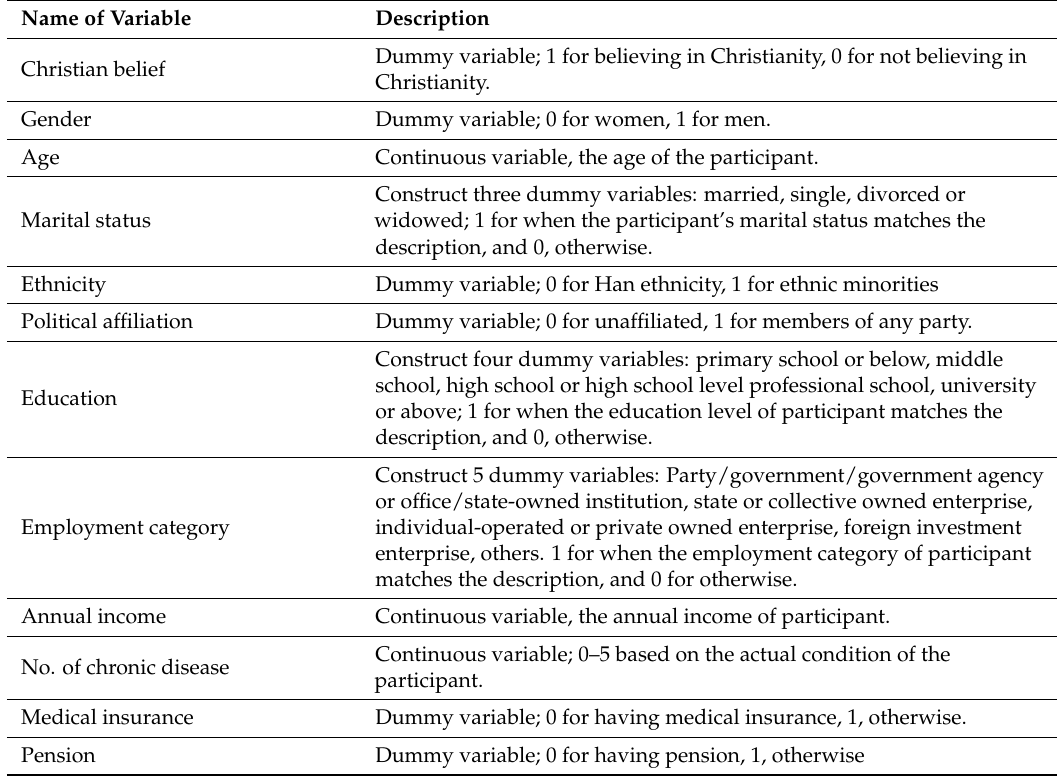
Table 3. Definition of the main